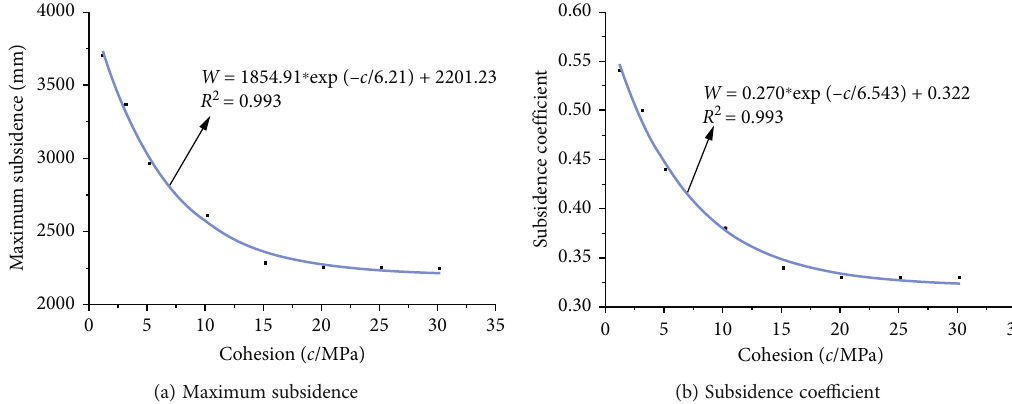
Figure 17: Fitting curve of maximum subsidence/subsidence coe ffi cient and